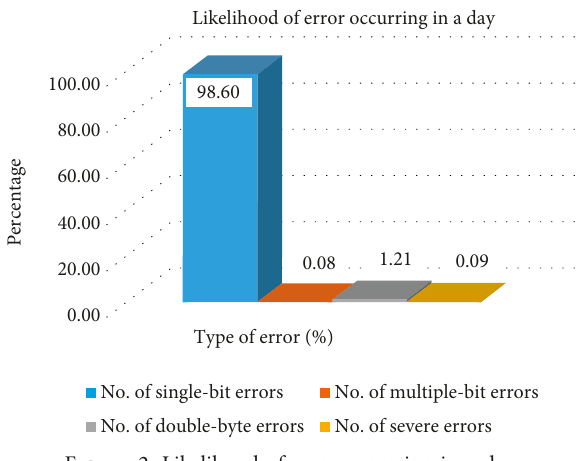
Figure 2: Likelihood of error occurring in a